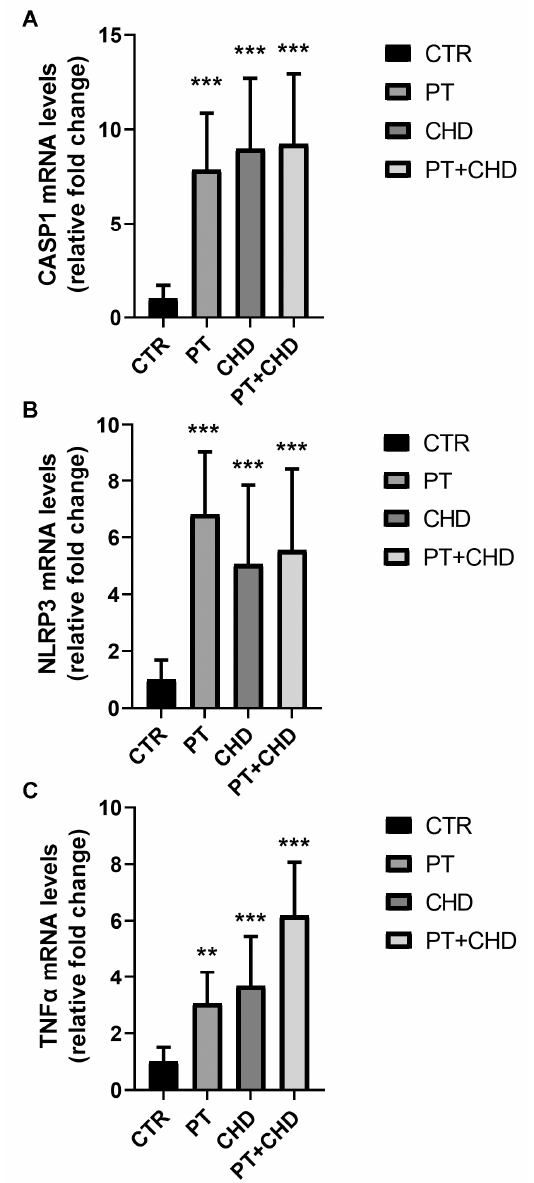
Figure 3. Analysis of CASP1 ( A ), NLRP3 ( B ), and TNF α ( C ) gene expression in PBMC from patients and healthy subjects. mRNA transcript levels were analyzed suing real-time PCR. The results are expressed as mean ± SD. ** p < 0.01 and *** p < 0.001 show significant differences in comparison to control subjects.